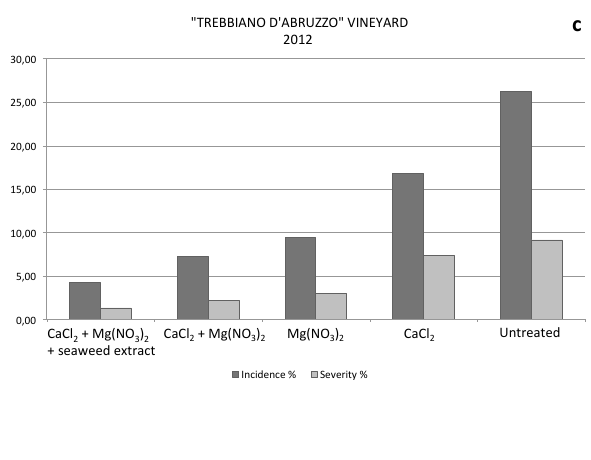
Figure 2. Incidence and severity of esca foliar symptoms in a Trebbiano d’Abruzzo vineyard (Teramo, Italy) follow- ing treatments with a mixture of CaCl 2 , Mg(NO 3 ) 2 and sea- weed extract (a, year 2010), and (b, c: 2011 and 2012) in the same vineyard following treatment with the same mixture and its single components.